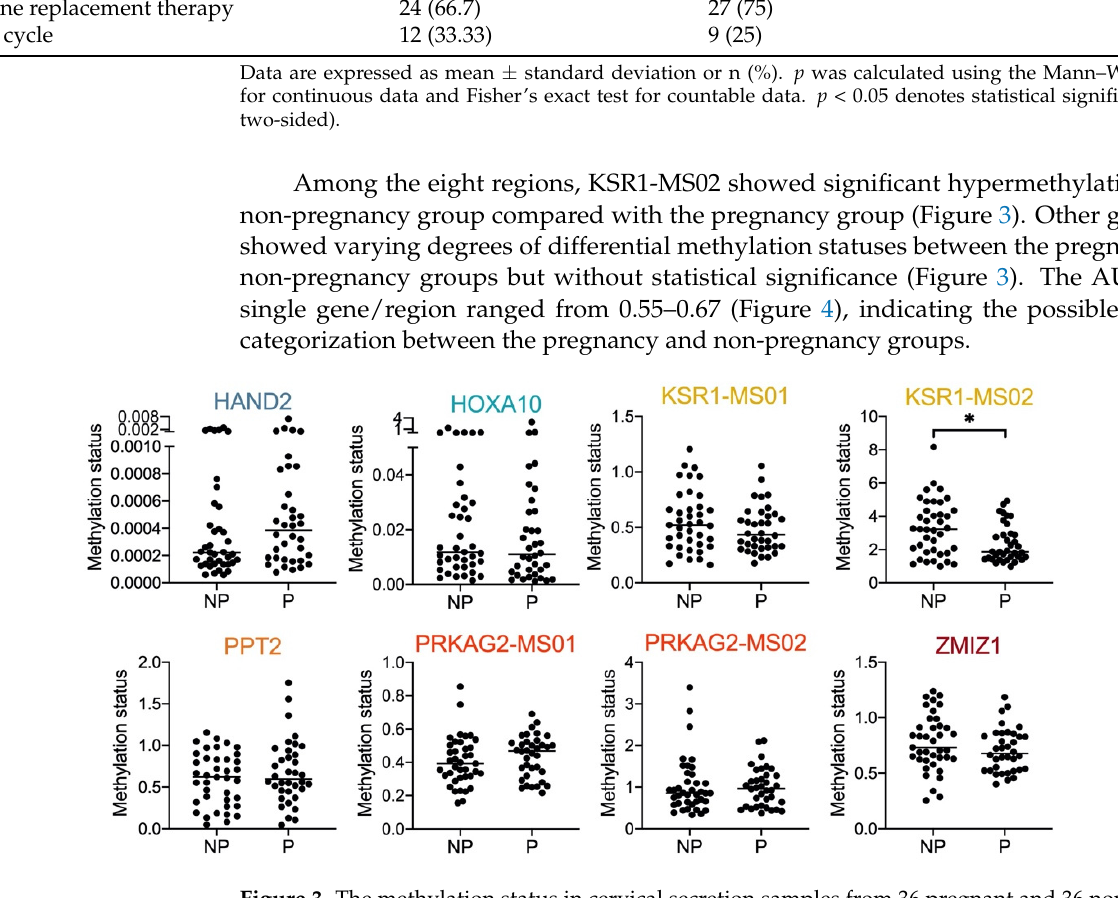
Figure 3. The methylation status in cervical secretion samples from 36 pregnant and 36 non-pregnant subjects with qMSP. * p < 0.05.